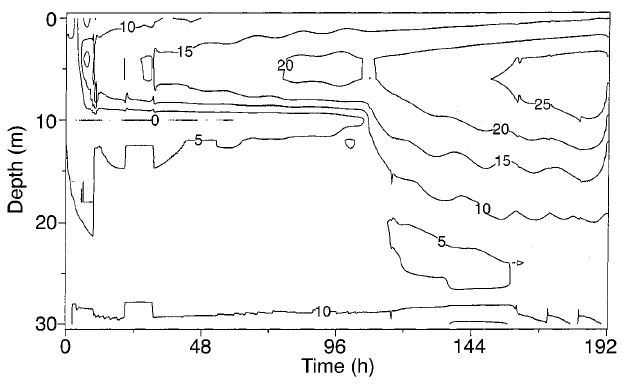
Fig. 3. Optimal turbulent viscosity (cid:133) cm 2 (cid:1) s (cid:255) 1 (cid:134) . The contour inter- vals are 5cm 2 (cid:1) s (cid:255)